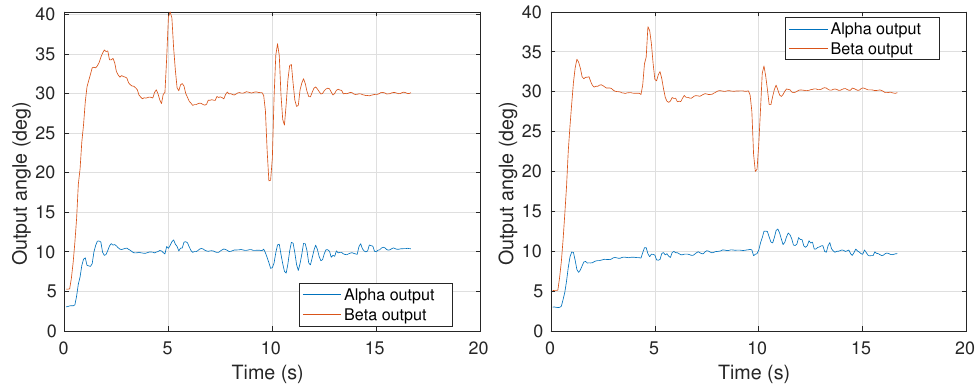
Figure 11. Experiment 2. Disturbance rejection. Time response for the two controllers tested, fractional ( left ) and integer ( right )